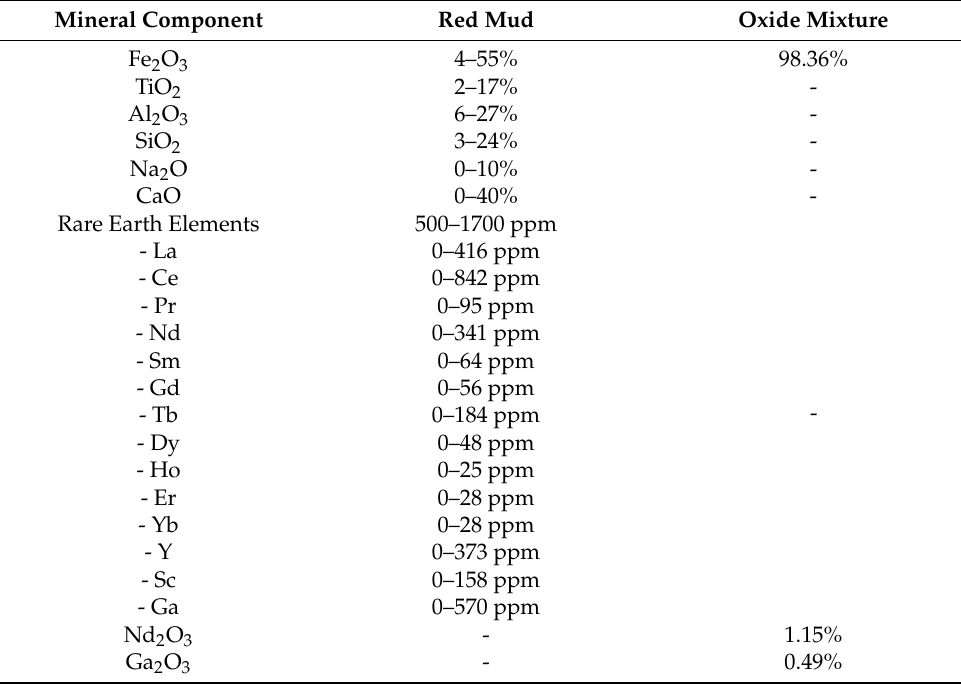
Table 2. The composition of mineral components in the red mud [6,22] and in the oxide mixture in this